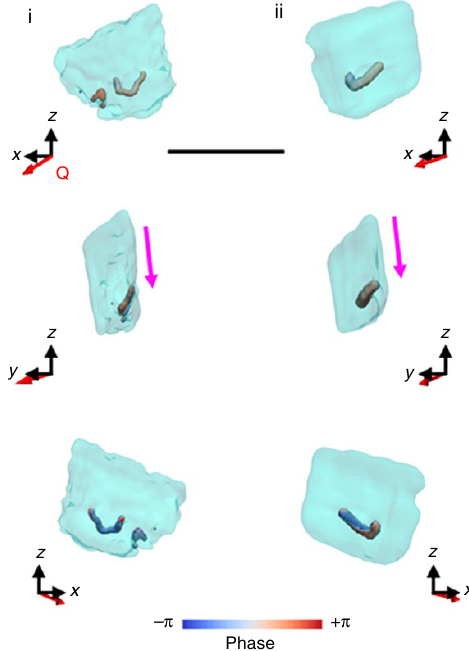
Figure 4 | Iso-surface rendering of the defects present within the oriented calcite crystals. The defects shown have a low electron density core that is surrounded by a spiral deformation field/phase, and correspond to dislocation loops. In both crystals (i and ii) the plane of the loop is directed towards the truncation facet (pink arrow). Defects are given in respect to their location within the crystal, as given by semi-transparent projections of the electron density. Q is the scattering vector. Scale bar, 1.8 m m.